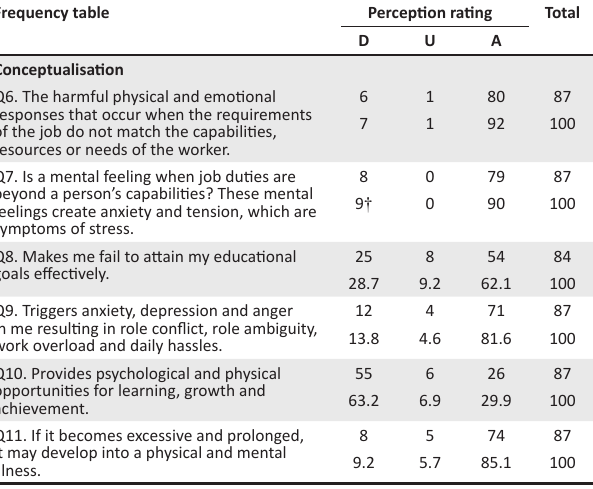
TABLE 1: Respondents’ perception of the concept of stress ( n = 87). Frequency table Perception rating Total